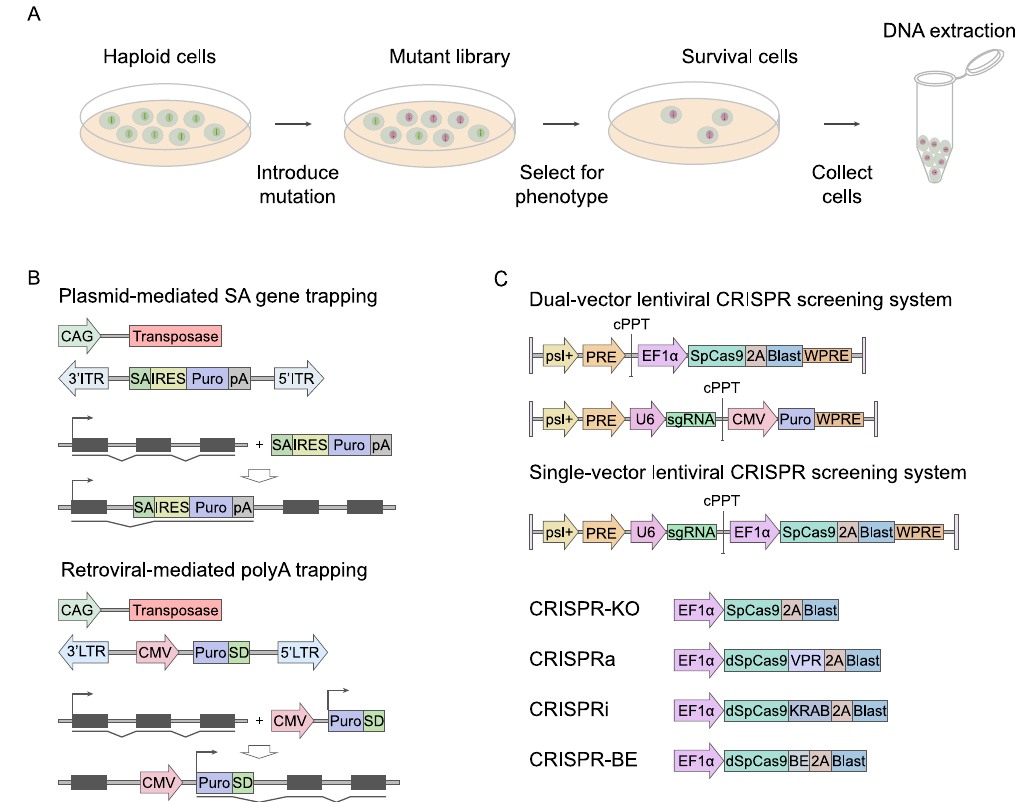
Figure 3. Applying haploid stem cells for functional genomics. (A) Forward genetic screens are powerful tools for the discovery and functional annotation of genetic elements. Three major steps are: mutagenesis to generate high-throughput mutant libraries, selection for the phenotype of interest, and mapping of mutations. (B) Two types of delivery systems used in gene trapping, the plasmid system and the retroviral system. (Top) Schematic diagram of splice acceptor (SA) gene trap, in which transposon elements were integrated in a plasmid vector. Splicing to upstream exons results in gene trap fusion transcript from which puromycin (puro) is transcribed by an endogenous promoter. CAG, a constitutive promoter; IRES, internal ribosome entry site; pA, poly A; ITR, inverted terminal repeat. (Bottom) Schematic diagram of ployA-trap, in which transposon elements were integrated in a retroviral vector. Insertion of a constitutive promoter-driven marker gene into introns results in a gene trap fusion transcript from which puromycin (puro) is terminated by an endogenous polyadenylation site. CMV, a constitutive promoter; SD, splice donor. LTR, long terminal repeat. (C) Schematic diagram of lentiviral expression vector for SpCas9 and sgRNA in a dual-vector form and single-vector form. psl +, Psi packaging singal; PRE, Rev response element; cPPT, central polypurine tract; EF1 α , elongation factor 1 α promoter;